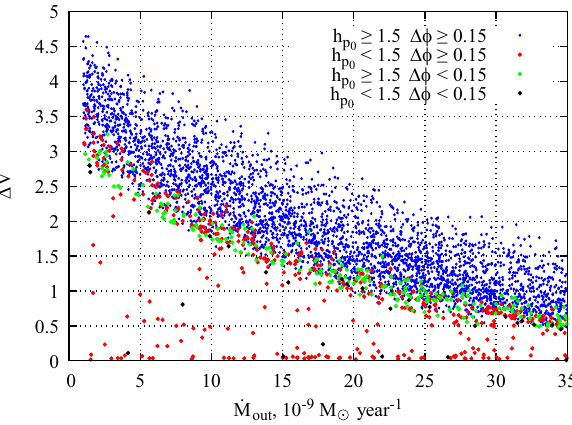
Figure 11: Dependence of the eclipse depth on the mass out fl ow rate for the eclipse models from Figure 9. The color dots present di ff erent ranges of ϕ Δ and h Δ p